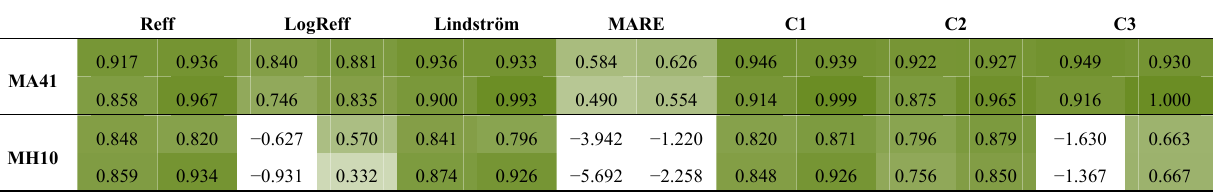
Table 7. Nash-Sutcliffe efficiencies between objective functions (horizontal) and streamflow characteristics (vertical) based on observed respective simulated streamflow (for each group of four values: upper − left = calibration period 1 (Cal1), upper − right = validation period 2 (Val2), lower − left = validation period 1 (Val1), lower − right = calibration period 2 (Cal2)). Colors are ranging from white (for Nash-Sutcliffe efficiencies of 0 or lower) to dark green (for a Nash-Sutcliffe efficiency of